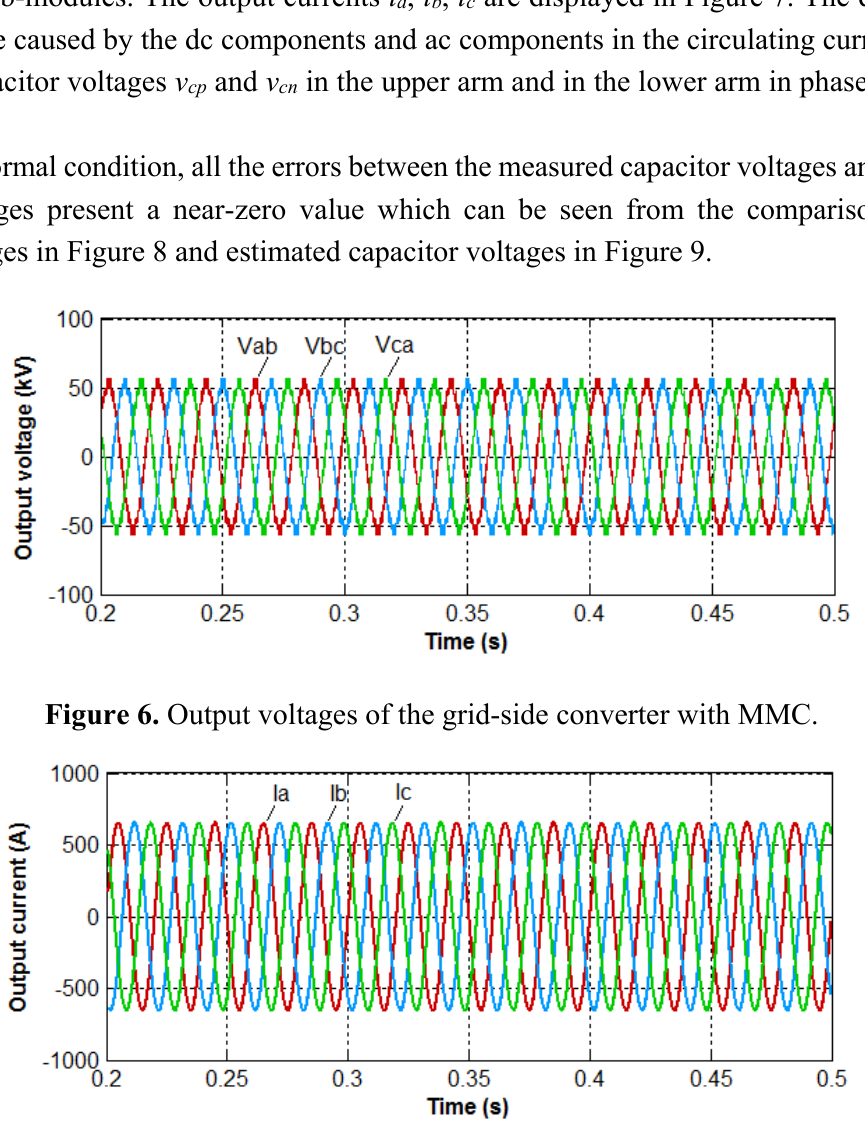
Figure 7. Output currents of the grid-side converter with MMC.